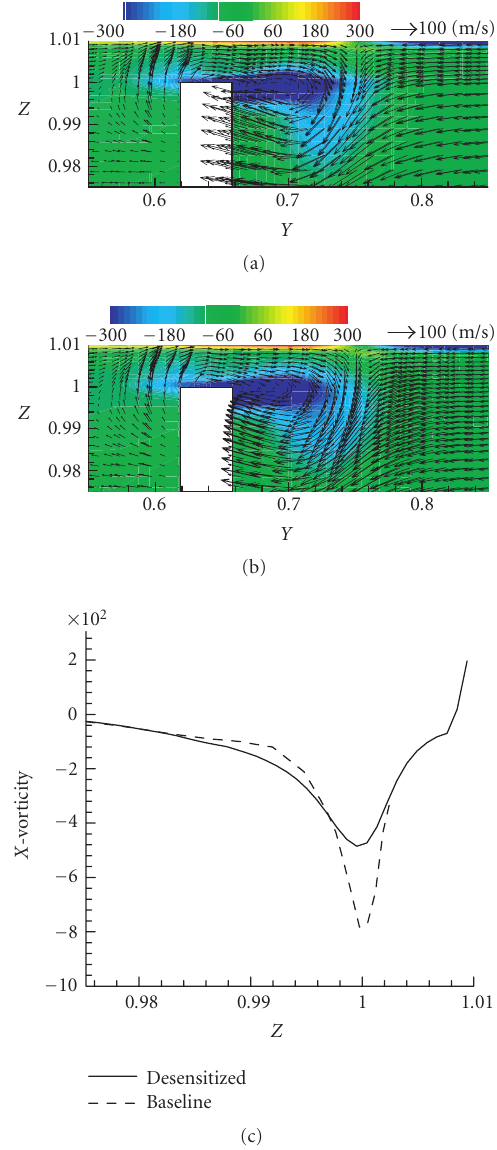
Figure 14: Tip leakage secondary vortices for (a) baseline squealer tip, (b) desensitized squealer tip, and (c) the relative magnitude of vortices along the blade span for a constant y = 0 . 7 at a streamwise location of 40% from the leading edge of the